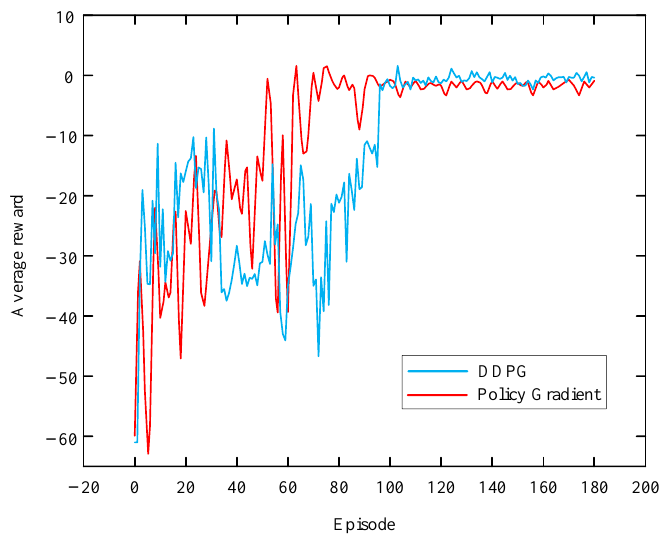
Figure 14. Comparison curve of average reward of the track planning module changing with the number of training wheels.